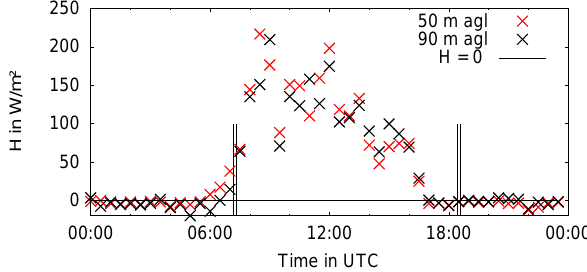
Fig. 6. Vertical sensible heat flux H measured at the tower at the measurement site on 21 July 2009. The values are averaged over 30min. Vertical lines mark the ascends and descents of the instan- taneous profiles performed by the M 2